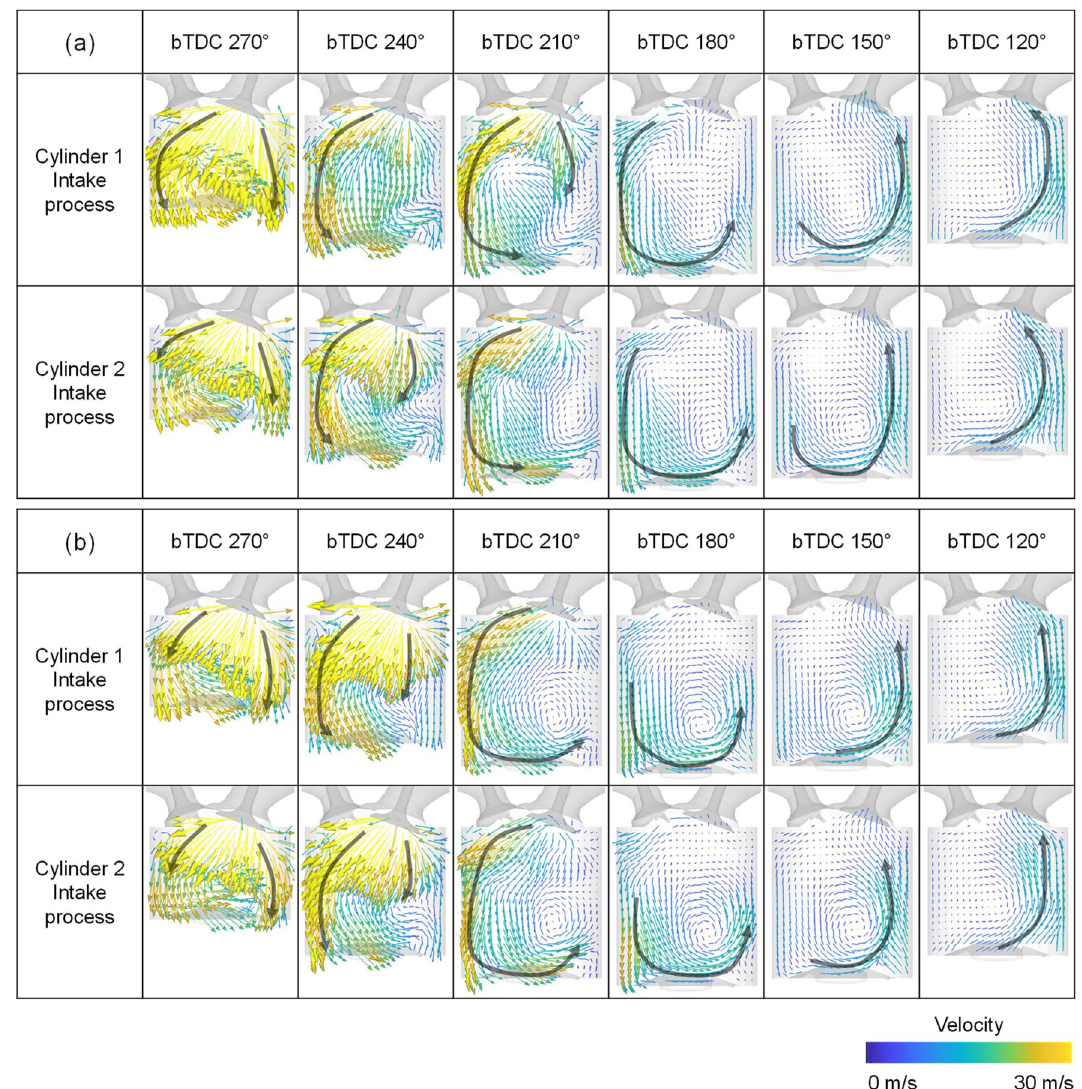
Figure 19. Velocity distribution in tumble plane of cylinder 1 at engine speed of 2000 rpm and intake pressure of 1.0 bar: ( a ) curved intake manifold, ( b ) straight manifold.